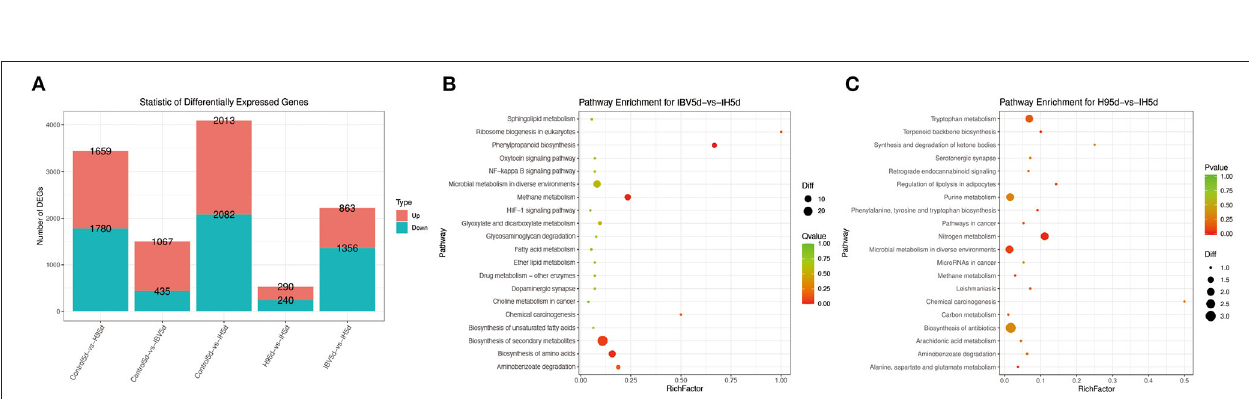
FIGURE 13 | Results of transcriptome analysis. (A) Statistical graph of the number of DEGs between samples. Top 20 enriched pathways based on DEGs in IBV-vs-IBV/H9N2 (B) and H9N2-vs-IBV/H9N2 (C) . Rich factor is the ratio of the number of DEGs noted in the pathway terms to all gene numbers noted in this pathway term. A greater rich factor indicates higher intensiveness. Q -value is the corrected P -value ranging from 0 to 1 (green). A lower Q -value indicates higher